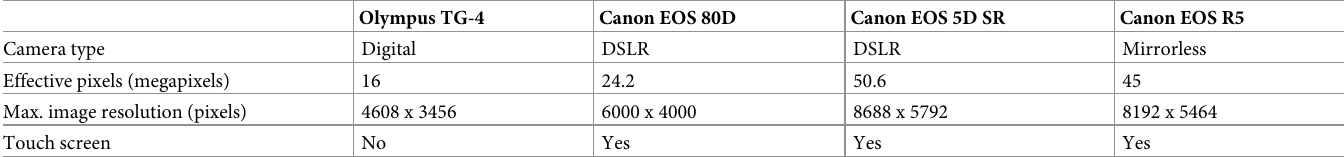
Table 1. Specification of the camera bodies used in the experimental